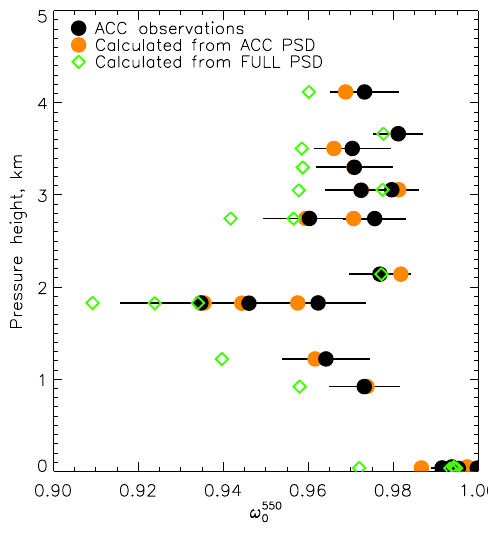
Figure 12. Variation in SSA at 550nm with altitude for SLRs. Black circles indicate direct measurements taken in-cabin behind inlets and therefore represent the accumulation mode (ACC PSD) only. Orange circles indicate calculated properties, representative of the same conditions in-cabin behind inlets for the ACC PSD. Green diamonds indicate values calculated using the 2-DS-XY FULL PSD covering size ranges 0.1 to 200µm. Green and orange data points are from Mie calculations;s black represents